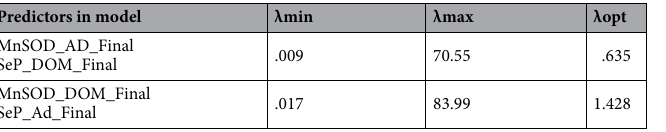
Table 2. Optimal λs computed from R packages grplasso and grpreg for indicated models. λmin computed by package grpreg using a Bayesian Information Criterion λmax was computed by package grplasso.